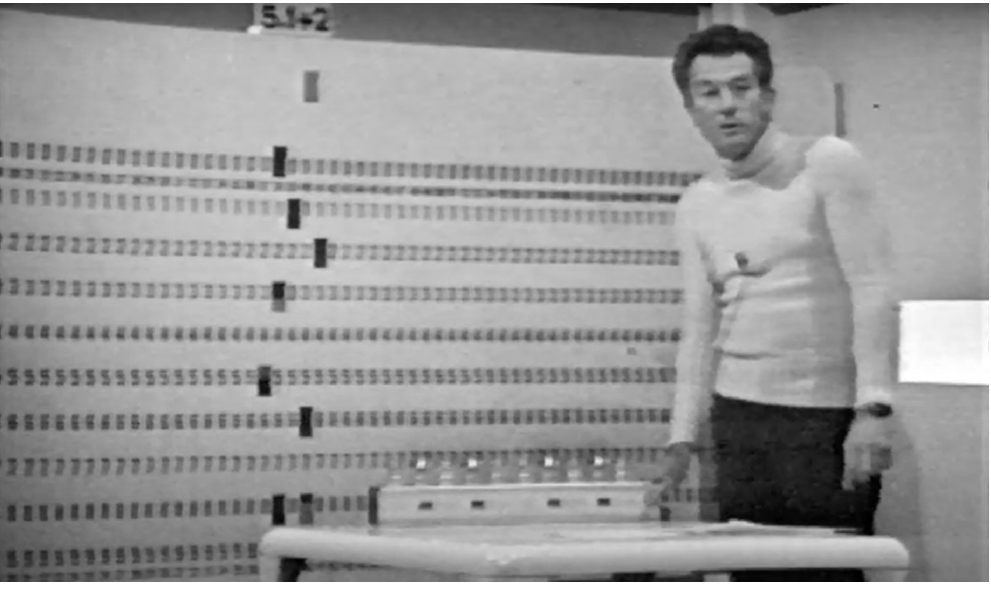
Fig. 5 Frame from the television didactic program L’Informatica with prof. Grasselli